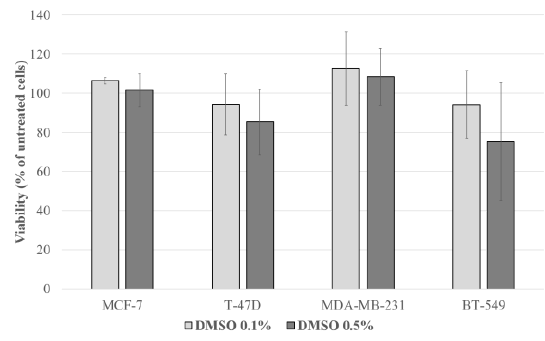
Figure 2: Effects of DMSO on cell viability of MCF-7, T-47D, MDA-MB-231 and BT-549 cells af- ter 7 days of treatment at a concentration corre- sponding to the highest alpelisib concentration (0.5 % DMSO ≙ 1000 ng/ml alpelisib) and in a con- centration corresponding to a lower alpelisib con- centration (0.1 % DMSO ≙ 100-500 ng/ml al- pelisib). The results are shown as the mean ± standard deviation of three separate experiments. Statistical significance was assumed at * p<0.05, ** p<0.01 and ***